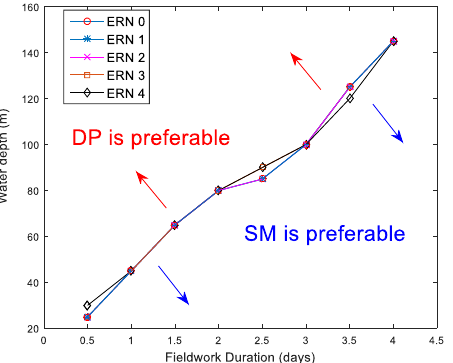
Figure 12. Decision-making plot for the geotechnical vessel with various ERNs.